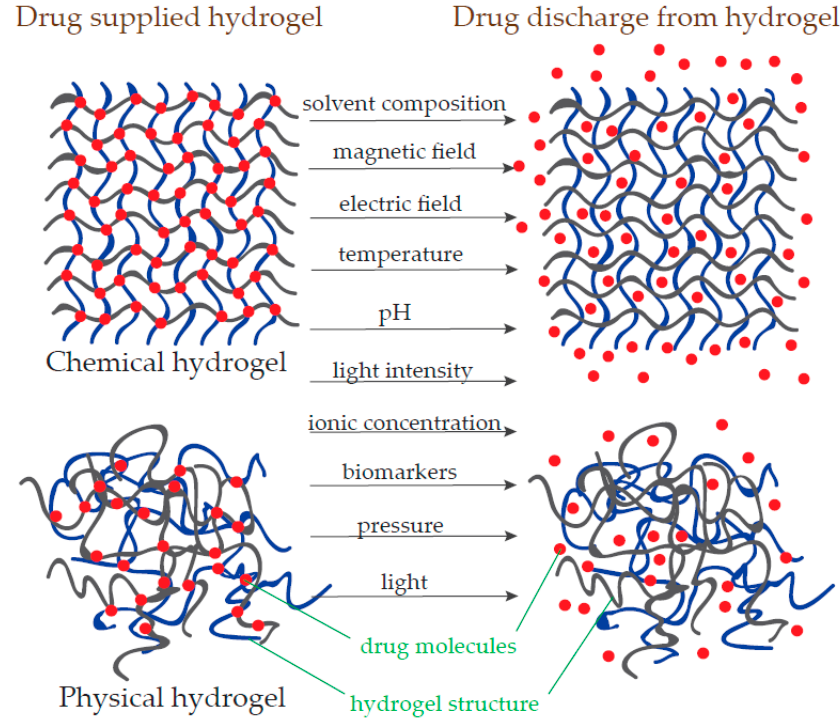
Figure 4. Hydrogel swelling and drug discharge with different physical or chemical